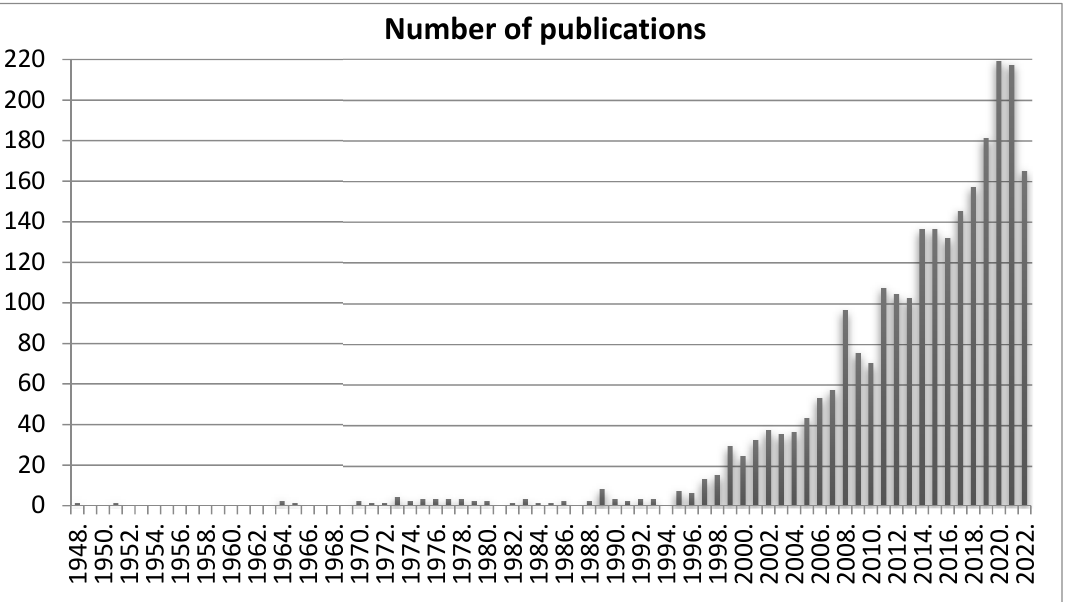
Figure 1. The number of publications for the entry “ketogenic diet neurological disease” in the PubMed base in the period from 1 January 1948 to 17 November 2022. Date of search: 17 November 2022.